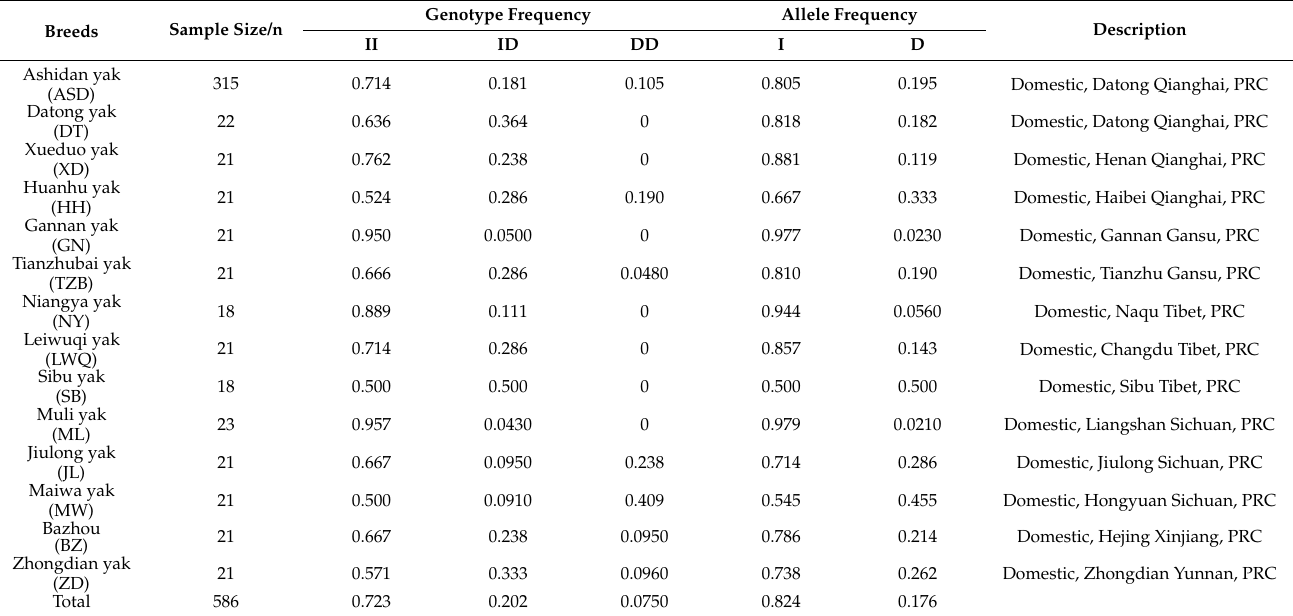
Table 2. Genotype and allele frequencies of GHR-SV246 in different Yaks.